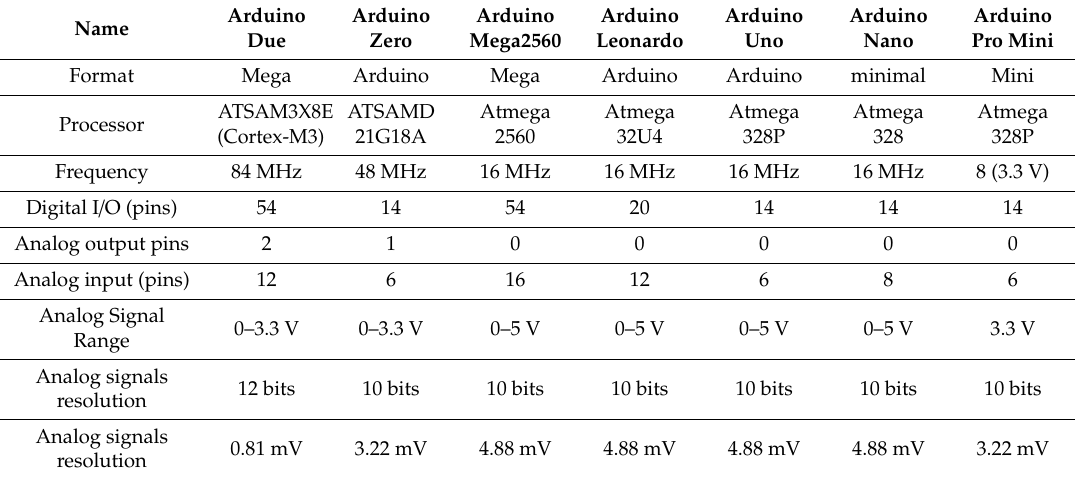
Table 1. Arduino Due characteristics.